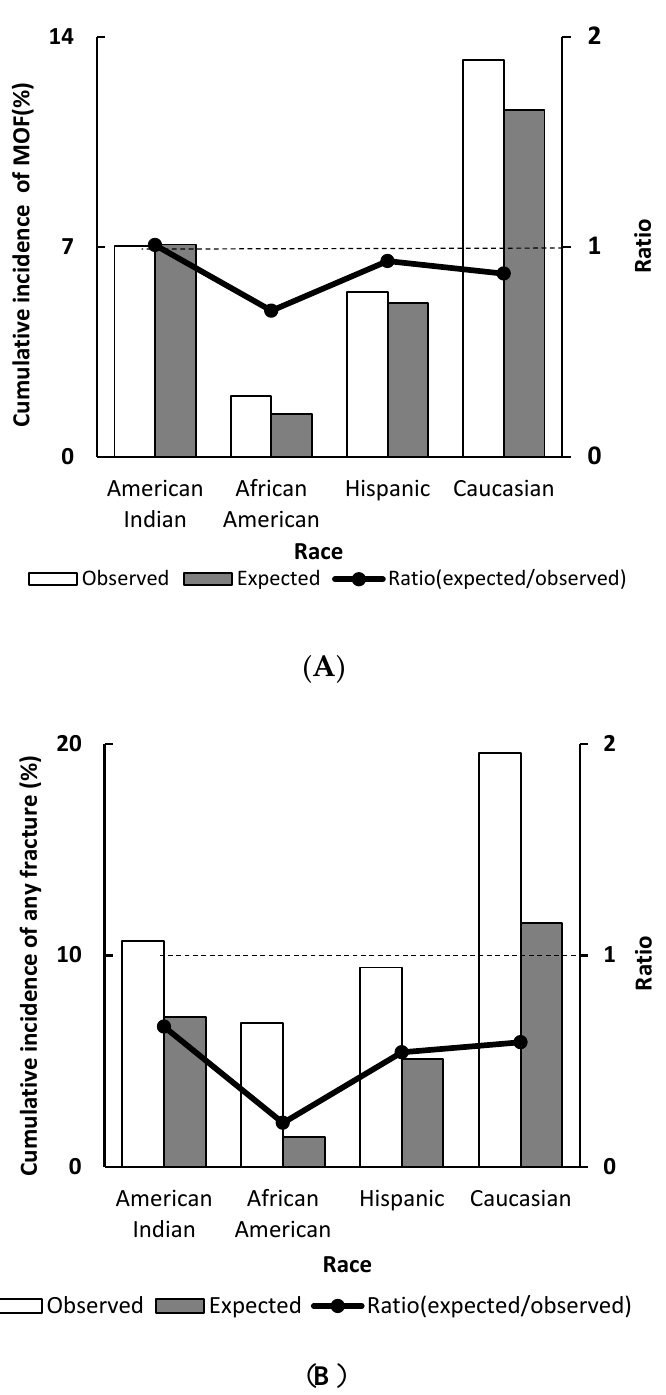
Figure A2. Observed versus predicted major osteoporotic fracture (A) and any fracture (B) probability stratified by race, 10 years of follow-up. The dotted line indicates a relative ratio of 1 (reference line); ratio <1 indicates that T-score underestimates fracture risk.